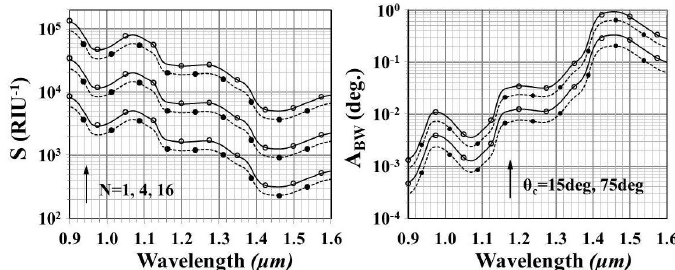
Figure 4. Sensitivity ( left ) and acceptance bandwidth ( right ), as a function of wavelength, for two indicative interfaces: CaF 2 / H 2 O (solid lines/open cicles) and SF 10/ H 2 O (dotted lines/black circles). Arrows indicate direction of increase in value of N (= 1,4,16 ) and θ c (=15 deg, 75 deg), respectively. Open circles correspond to exact values derived from signal-versus-incidence-angle plots, by use of Equations (2) and (6); solid lines are estimates from the empirical Equations (8) and